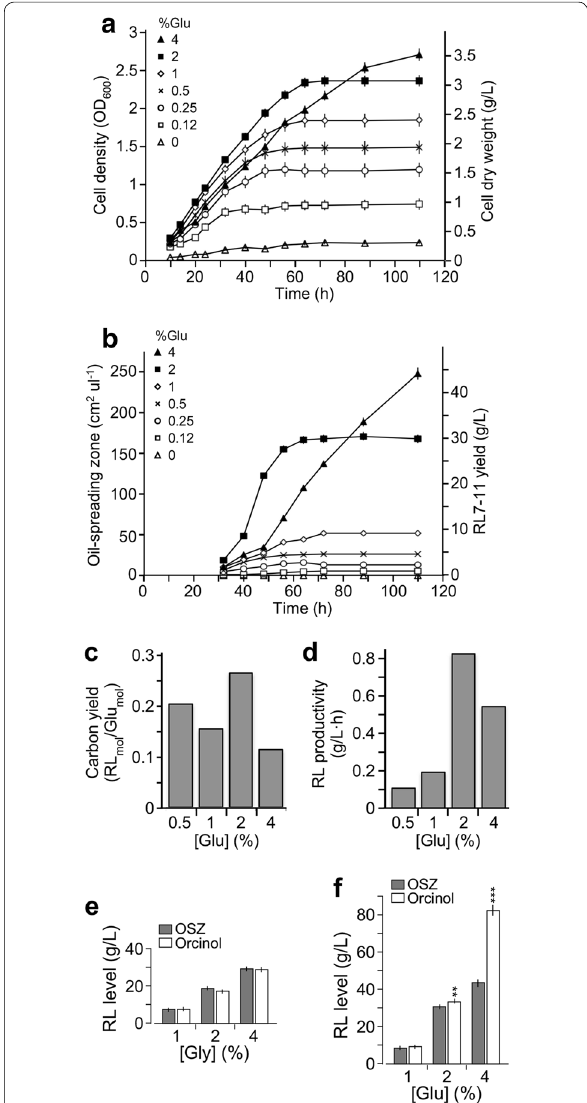
Fig. 4 Rhamnolipid yield by ZS1 isolate under various growth condi- tions. a Growth curve analysis of ZS1 cultures with various amounts of glucose supplements. X - and Y -axis indicate time in hour (h) and cell con- centration in optical density ( left ) or cell dry weight ( right ), respectively. b Change of surfactant activities during cell growth. X - and Y -axis indicate time (h) and oil-spreading zone (cm 2 /μl, left ) or RL7-11 concentration (g/l, right ). c Carbon yield or ratio between product RL7-11 and carbon source glucose in ZS1 cultures with various glucose supplements. X - and Y -axis indicate supplement glucose concentration and carbon yield in RL mol /Glu mol , respectively. d RL7-11 productivity in ZS1 cultures with vari- ous glucose supplements. X - and Y -axis indicate supplemented glucose concentration and RL7-11 productivity in g/l h, respectively. e Quantifi- cation of rhamnolipids by oil-spreading assay (OSZ) or orcinol method (Orcinol) in cultures with various glycerol supplement. No significantly differences between the two methods is observed. f Quantification of rhamnolipids by oil-spreading assay (OSZ) or orcinol method (Orcinol) in cultures with various glucose supplement. Significant difference between the two methods is apparent. Asterisk indicates the significant difference between the results by OSZ and